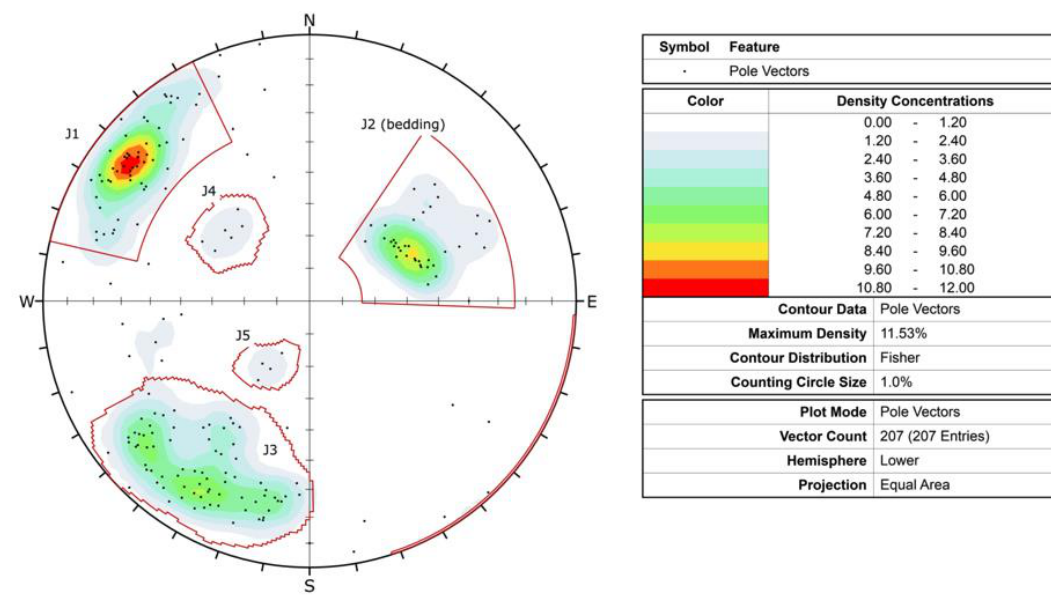
Figure 8. Virtually mapped discontinuity density contours in stereographic projection for Site S042 and manually identified joint sets.